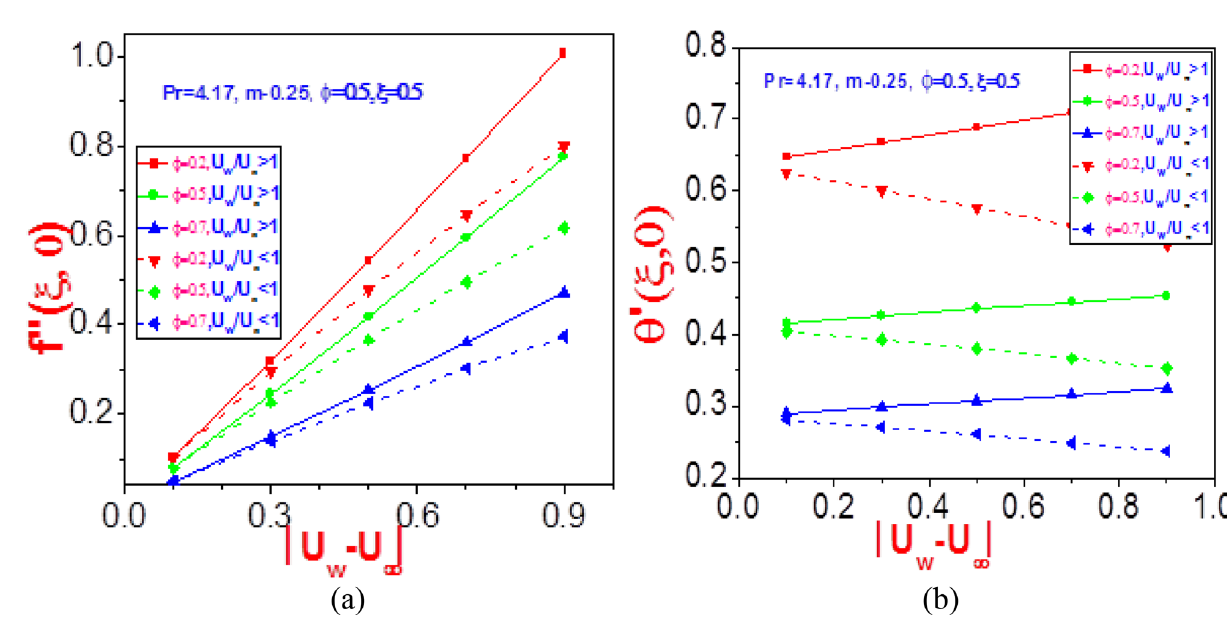
Figure 19. Profiles of ( a ) missing velocity slope f ′′ (ξ , 0 ) and ( b ) missing temperature slope θ ′ (ξ , 0 ) with different values of φ near wall (η = 0 )